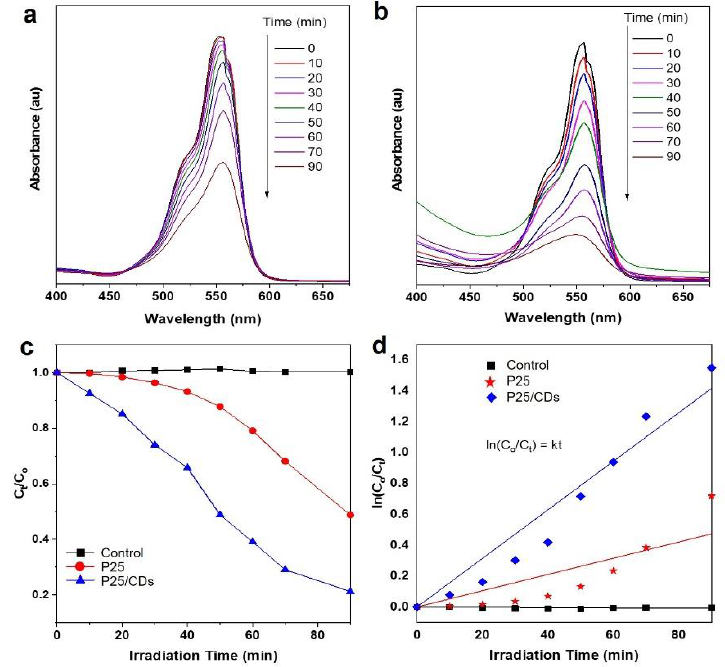
Figure 7. UV-Vis spectra of Rh-B degradation with ( a ) P25 and ( b ) P25/CDs under UV light at different irradiation times. ( c ) Photocatalytic degradation curves of P25 and P25/CDs at different times under UV light irradiation. ( d ) Pseudo-first-order fitted degradation of RhB by P25 and P25/CDs.